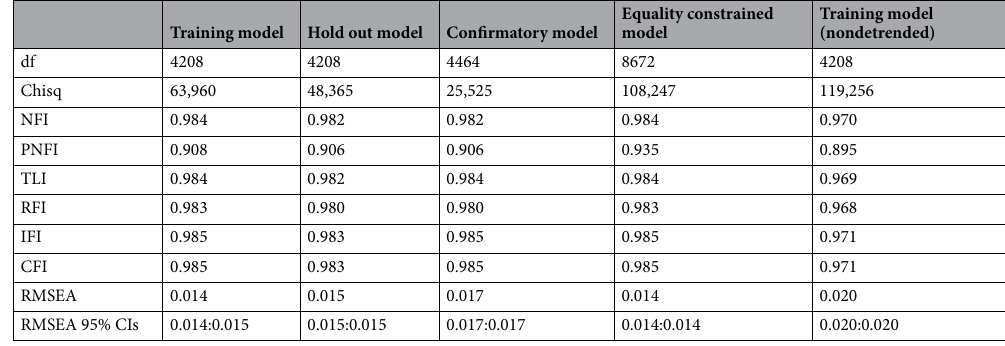
Table 3. Fit statistics across panel graphical VAR